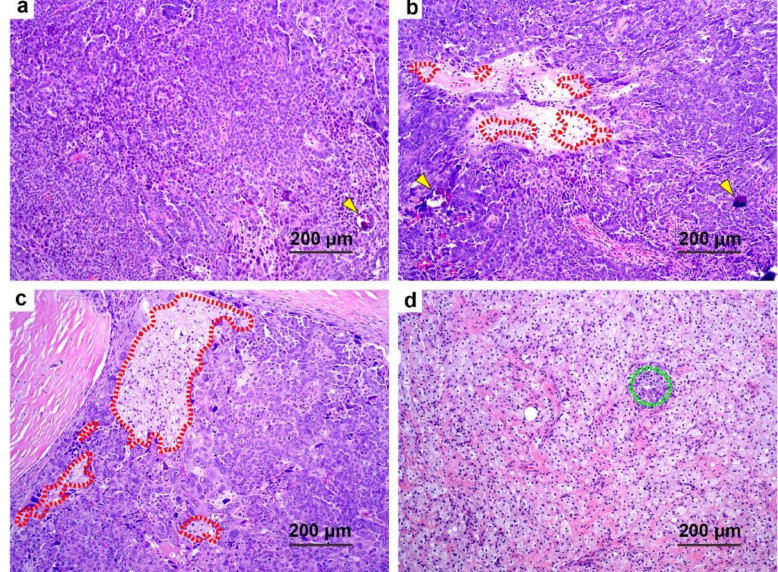
Figure 5. A representative example illustrates the scoring criteria of additional histopathologic features associated with treatment. Different grade foamy histiocytes response to neoadjuvant chemotherapy (H&E staining; scale bars: 200 µ m). ( a ) 0: No foamy histiocytes response; ( b ) 1: foamy histiocytes < 5% (areas of red, dotted line); ( c ) 2: foamy histiocytes 5–50% (areas of red, dotted line); ( d ) 3: foamy histiocytes > 50%, massive foamy histiocytes infiltrate around a tumor cell nest (the area of green, dotted line). Yellow arrows indicate psammoma bodies ( a , b